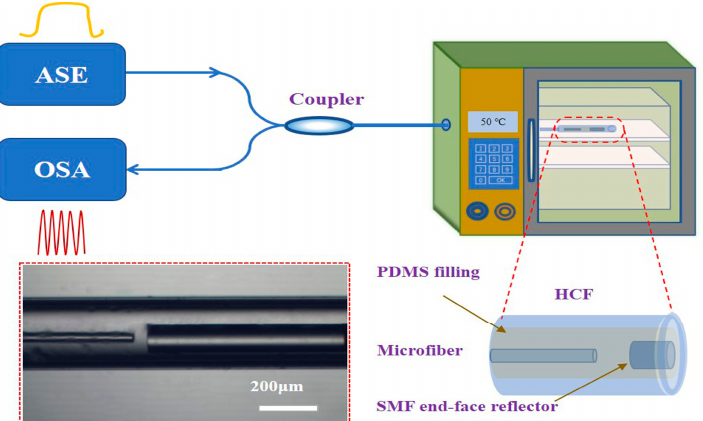
Figure 2. Experimental schematic of the microfiber and PDMS-based Fabry-Perot interferometer for sensing temperature. The light source, temperature sensor and spectrometer were contacted by a 1 × 2 coupler. The enlarged schematic and microscope picture of the temperature probe were illustrated.